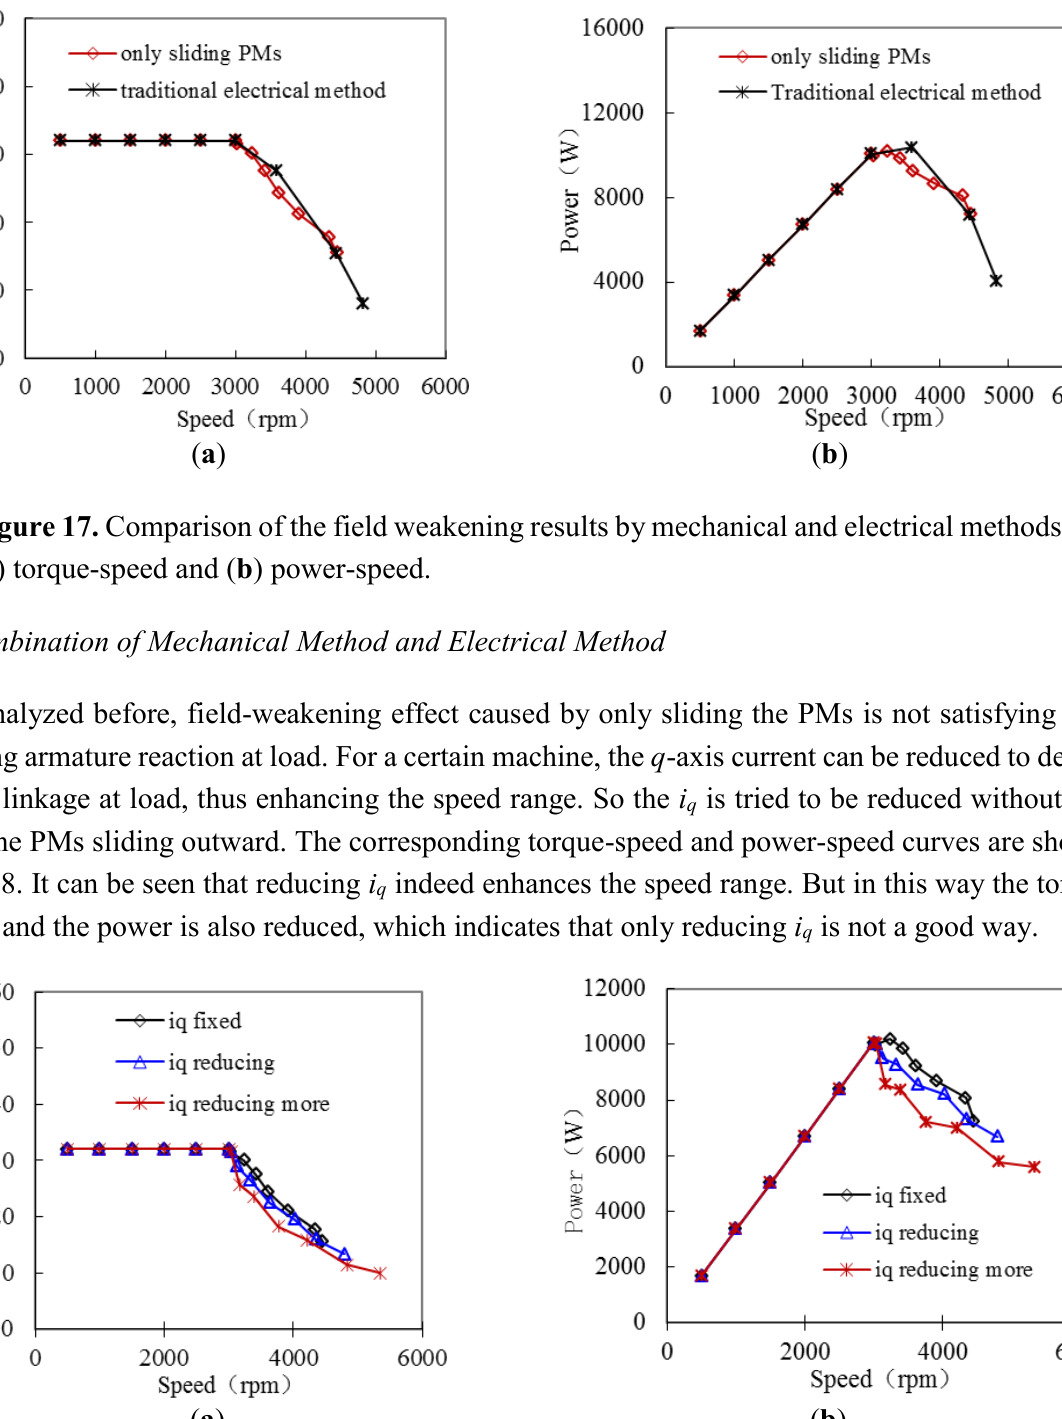
existing: ( a ) torque-speed and ( b ) q